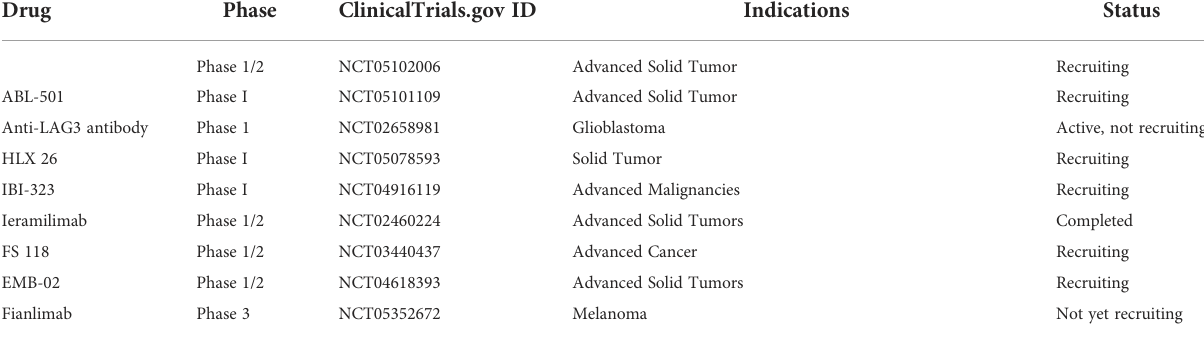
(Table 1). As the fi rst anti-LAG3 human IgG4 monoclonal antibody and novel immune checkpoint inhibitor, relatlimab, discovered by Bristol-Myers Squibb, is currently undergoing 46 different clinical trials for cancer therapy (65). As the fi rst commercially developed anti-LAG-3 antibody, relatlimab entered the clinical trials in 2013 (66). However, due to the limited ef fi cacy of relatlimab alone, it is generally used in combination with other checkpoint inhibitors, including CTLA-4 inhibitors (ipilimumab) or PD-1 inhibitors (nivolumab), to synergistically improve the ef fi cacy (39). Encouragingly, relatlimab in combination with the PD-1